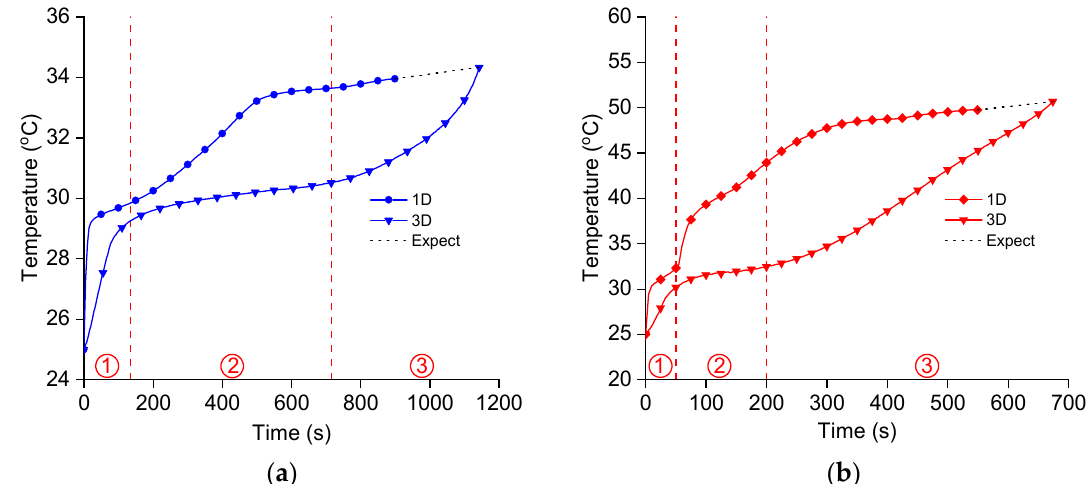
Figure 13. Comparison of 1D and 3D simulation results for battery temperatures under: ( a ) the 3C discharge rate; ( b ) the 5C discharge rate (1: sensible heating of solid; 2: latent heat of fusion; 3: sensible heating of liquid).